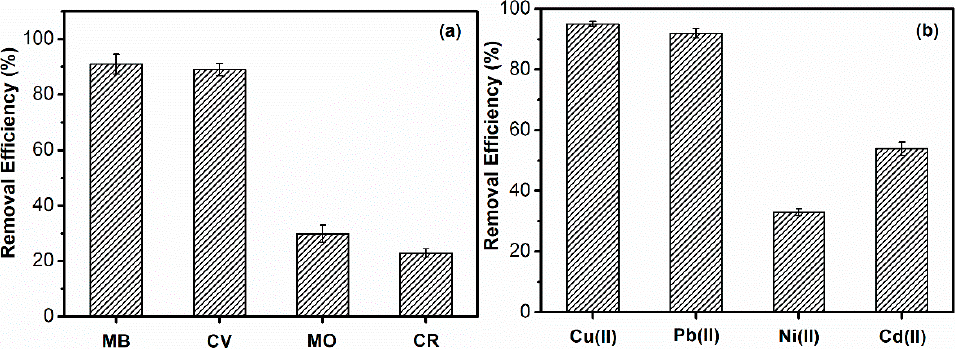
Figure 4. The adsorption efficiency of removing ( a ) dyes and ( b ) heavy metal ions by SPCT.